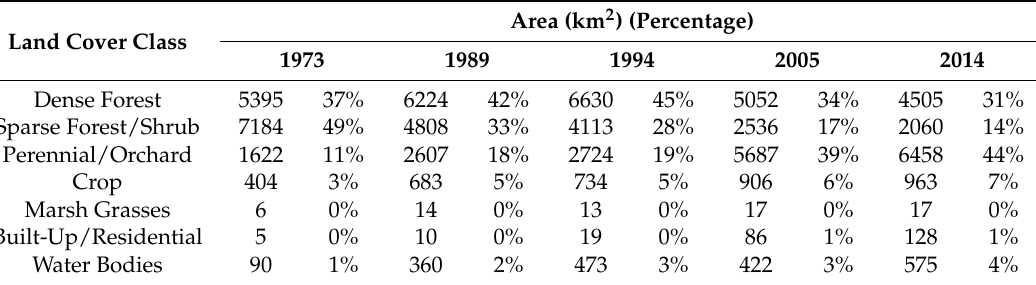
Table 4. Area and proportion of each land cover class in 1973, 1989, 1994, 2005, and 2014.